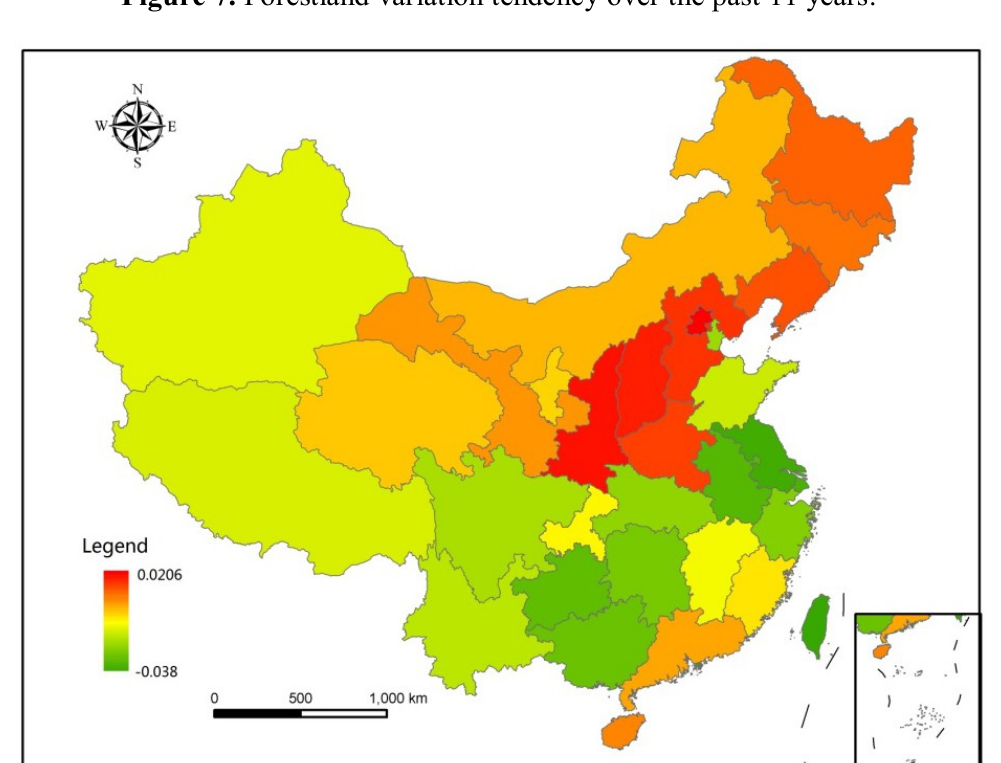
Figure 7. Forestland variation tendency over the past 11